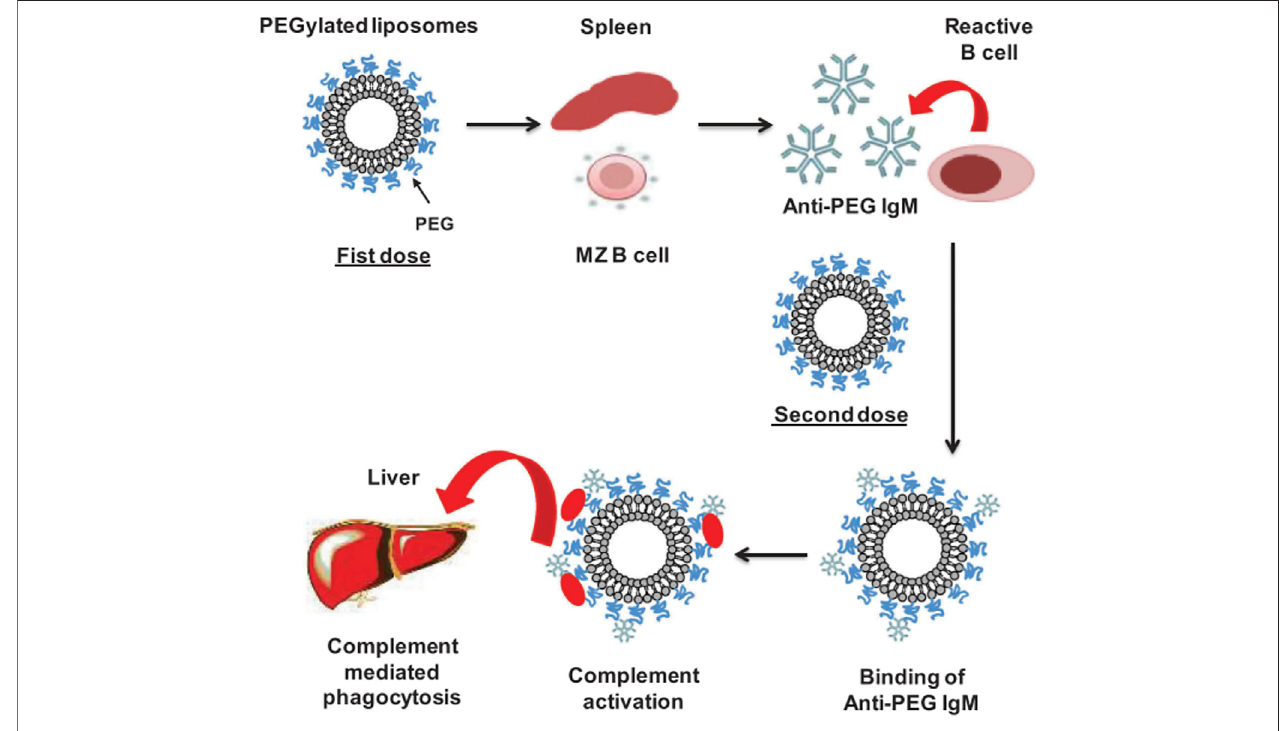
FIGURE 8 | ABC mechanism. The fi gure is taken from ref (Mohamed et al.,